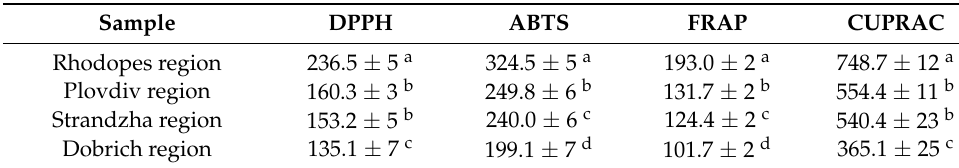
Table 5. Antioxidant activity in samples of Sambucus nigra L. blossoms from different regions